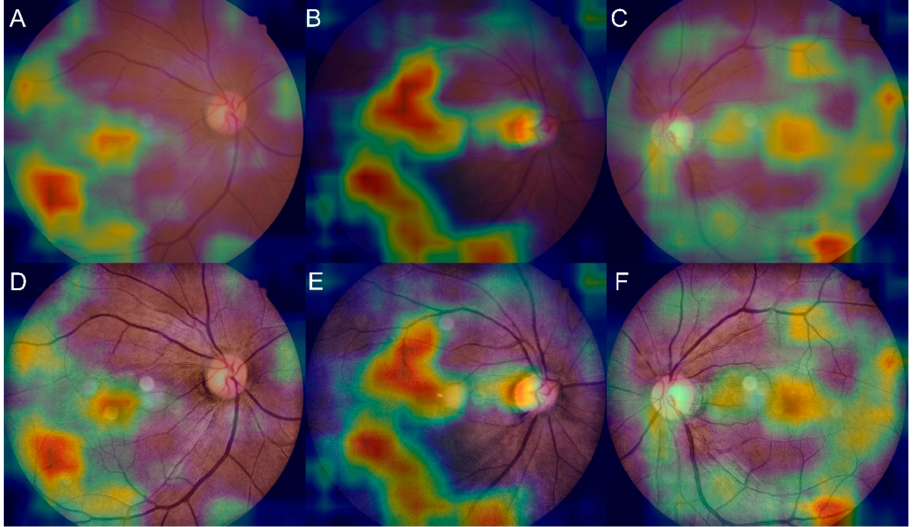
Figure 5. Representative examples of salience maps showing the area of strong attention as red for FS grade 2+ over ( A – C ) original fundus images and ( D – F ) pre-processed